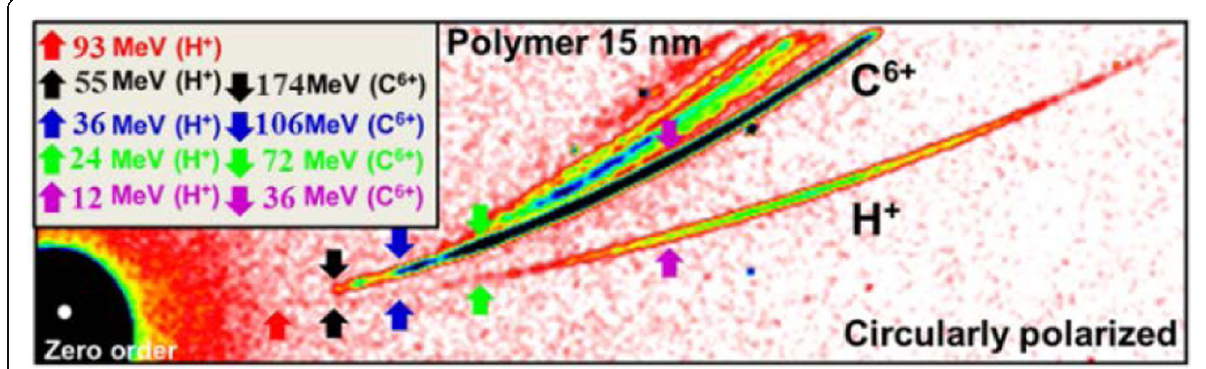
Fig. 19 Thomson parabola image from the RPA experiments at CoReLS. The spectral image of proton and carbon ions was obtained from a 15- nm-thick F8BT target irradiated with a circularly polarized laser pulse of an intensity of 6.1 × 10 20 W/cm